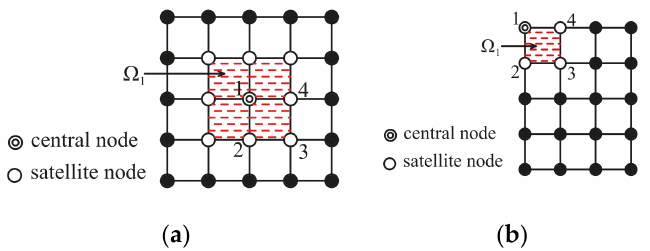
Figure 1. The nodal support domain of first order ( Ω i ) for a central node 1: ( a ) central node within computational domain; ( b ) central node on computational